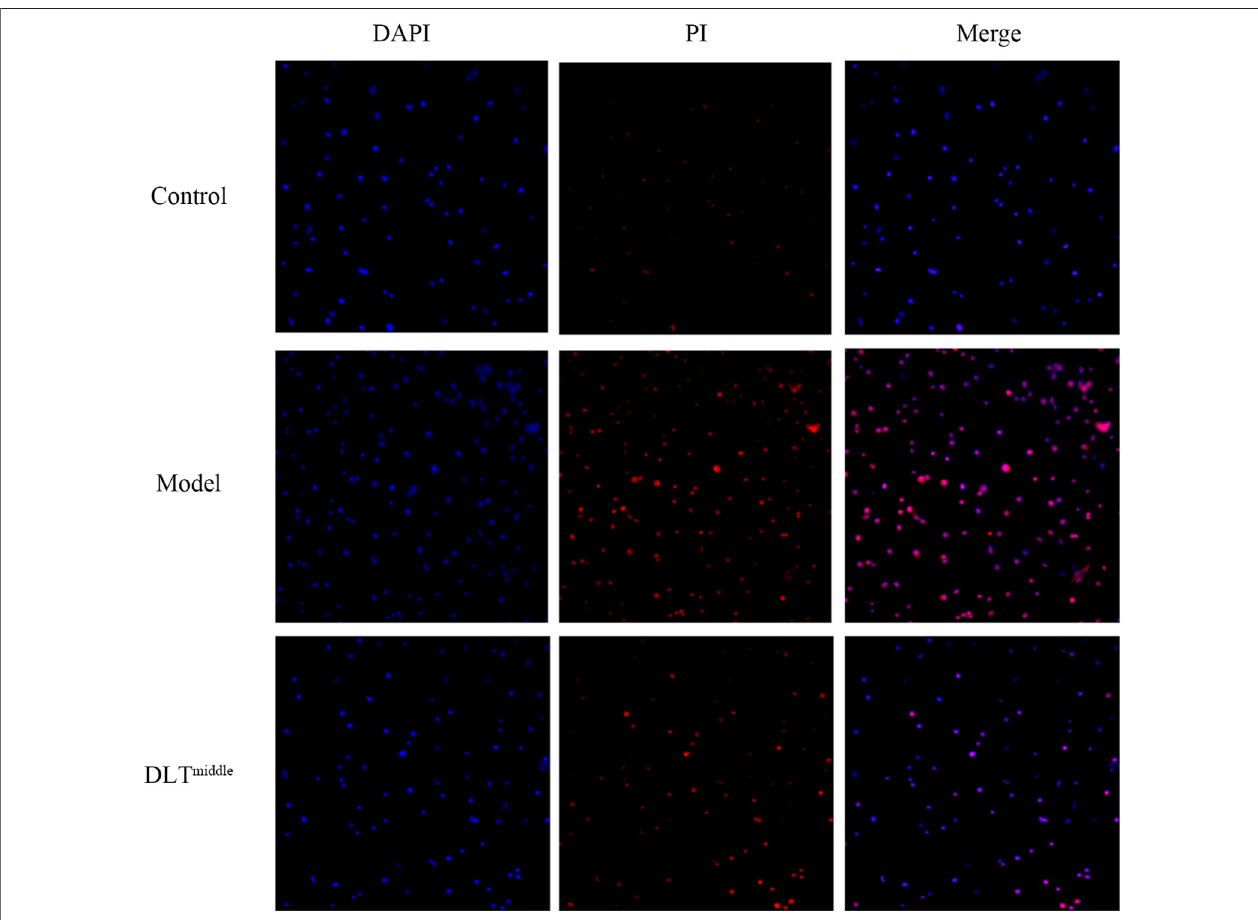
FIGURE 7 | DLTs suppressed apoptosis of BMDMs in vitro . Apoptotic cells were stained with DAPI and PI and observed by fl uorescence microscopy (magni fi cation × 100) after treatment withox-LDL and DLT middle .More cells withdeepened nuclear staining (merge) were seen inthe ox-LDL-induced BMDM group than in the control group, cells with deepened nuclear staining were signi fi cantly reduced after DLT treatment.